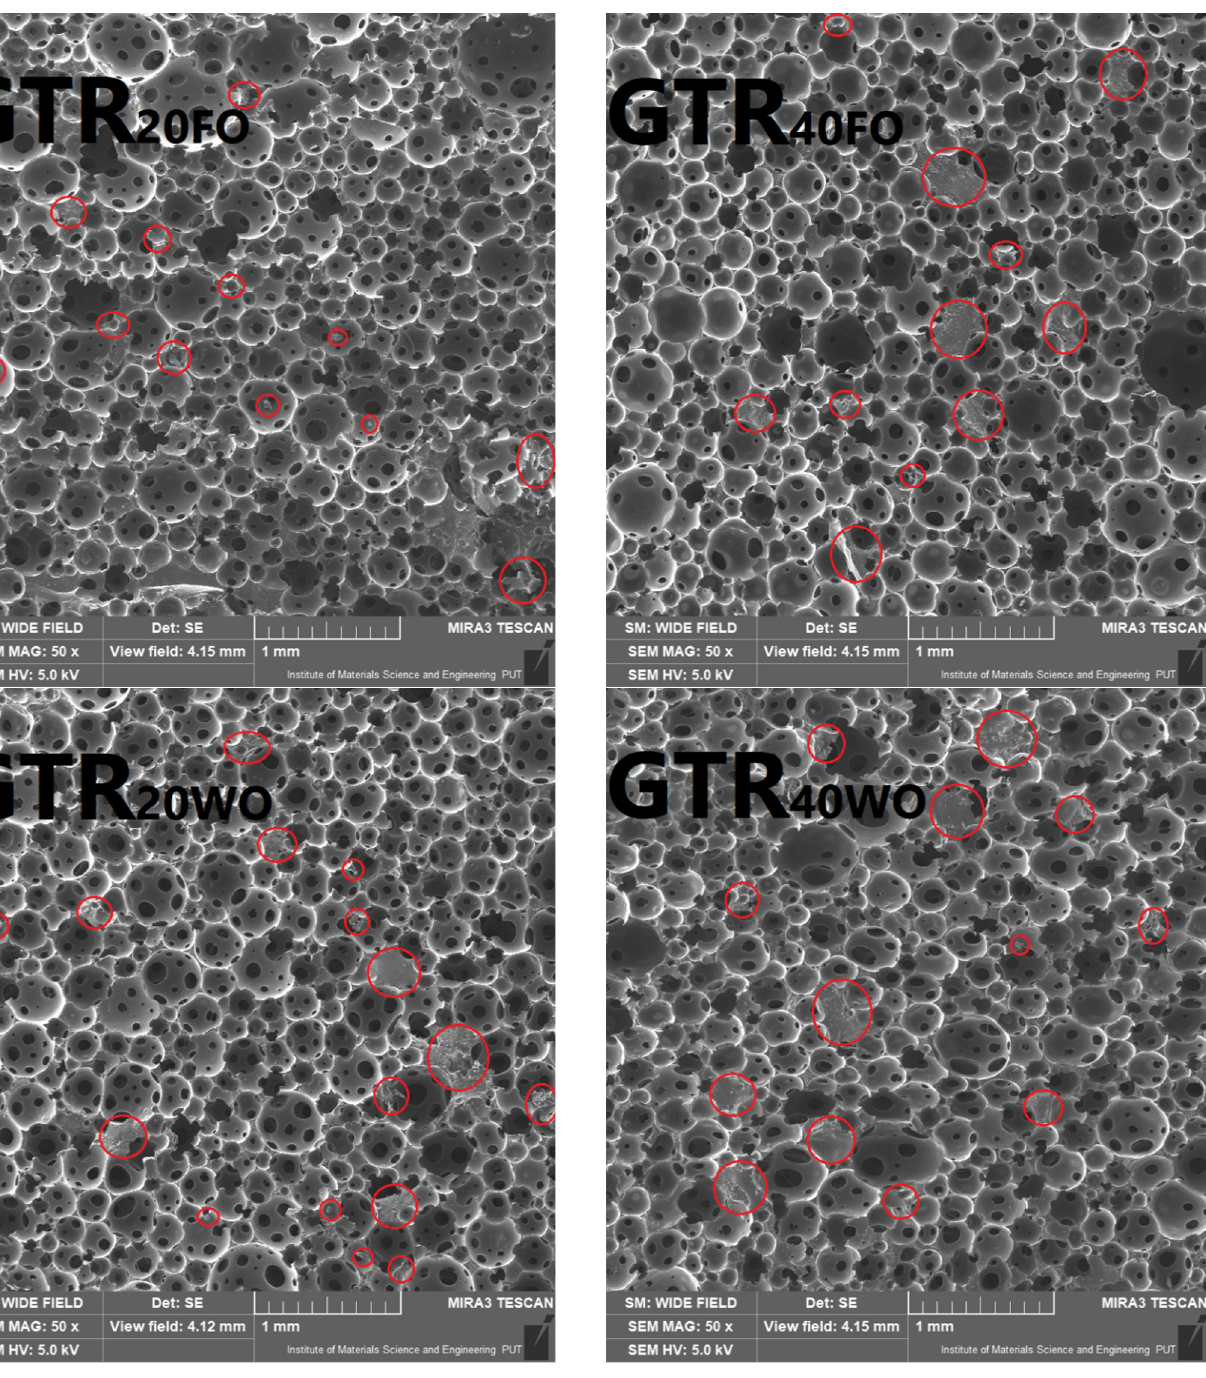
Figure 2. The SEM images showing the cellular structure of prepared foams (GTR particles marked with red circles).